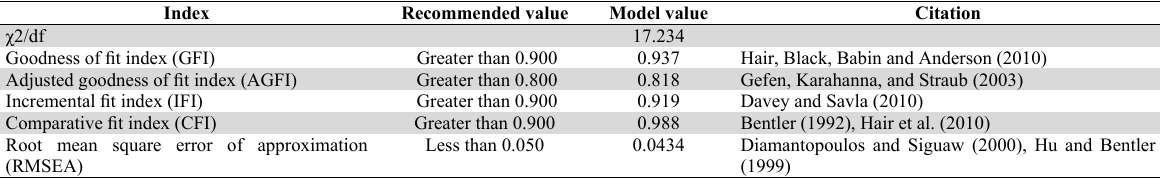
Model fit indices